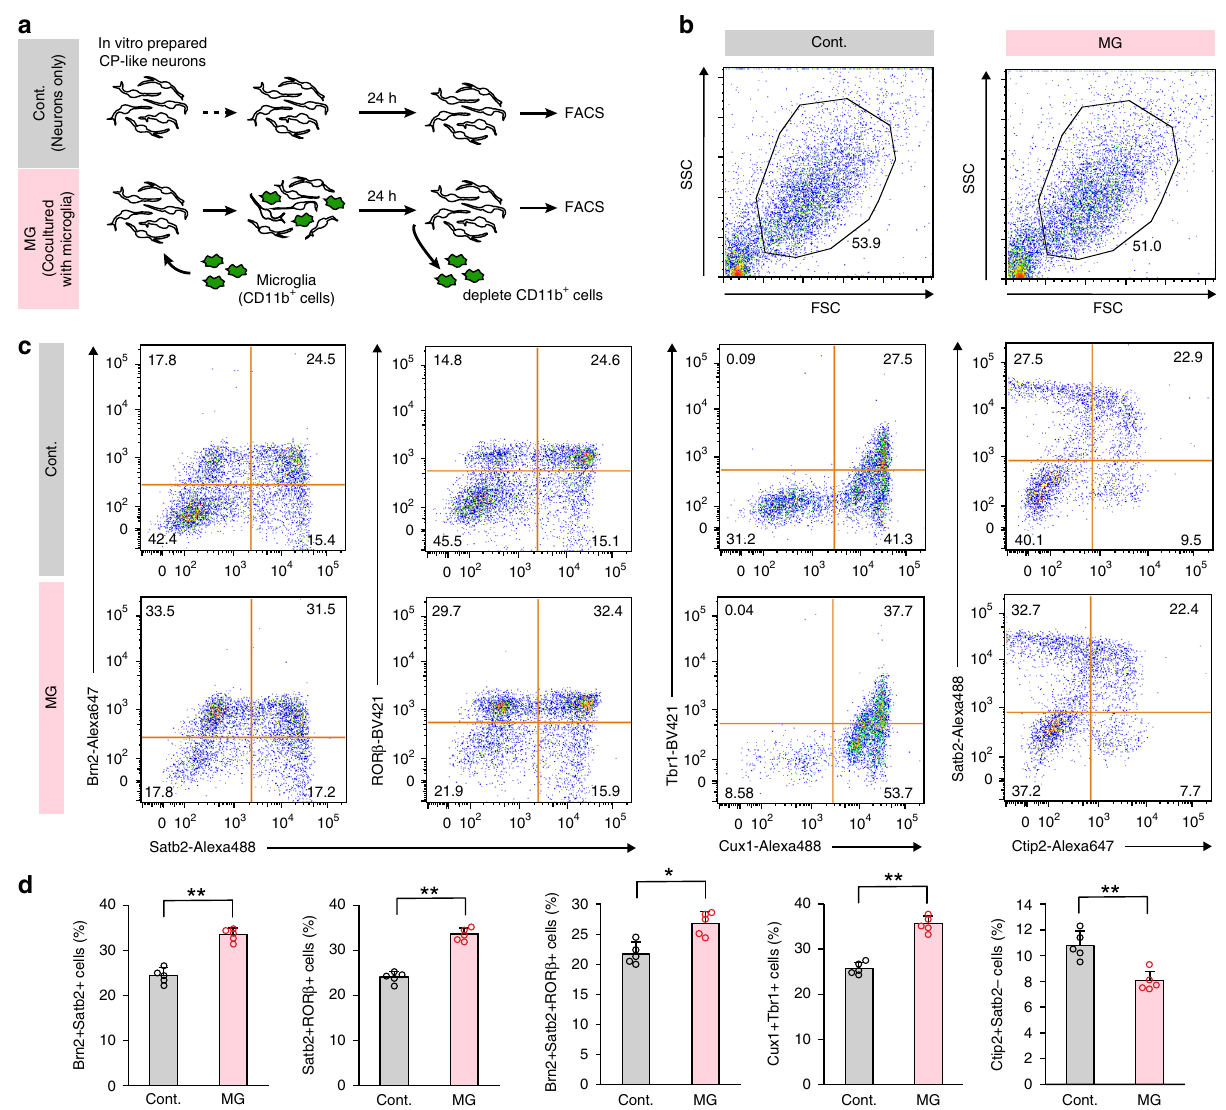
Fig. 6 FACS analysis for the detection of multiple subtype-associated transcription factors in microglia-cocultured neurons. a A schematic depicting the cell preparation technique used for FACS analyses. Neurons MG , cultures of CP-like neurons that were cocultured with microglia; neurons Cont , cultures without microglia. b FSC/SSC plots of neurons cultured with/without microglia, which were treated for intracellular staining. c Representative data of FACS analysis of in vitro-prepared CP-like neurons after coculture with or without microglia. d Graphs showing the average percentage of Brn2 + Satb2 + , Satb2 + ROR β + , Brn2 + Satb2 + ROR β + , Cux1 + Tbr1 + , and Ctip2 + Satb2 − cells, as determined by FACS (two-sided Mann – Whitney U test; n = 5 independent cell cultures; P = 7.9×10 − 4 for Brn2 + Satb2 + cells, P = 7.9×10 − 4 for Satb2 + ROR β + cells, P = 0.016 for Brn2 + Satb2 + ROR β + cells, P = 7.9×10 − 4 for Cux1 + Tbr1 + cells, and P = 7.9×10 − 4 for Ctip2 + Satb2 − cells). Data are presented as the mean values±S.D. Source data are provided as a Source Data